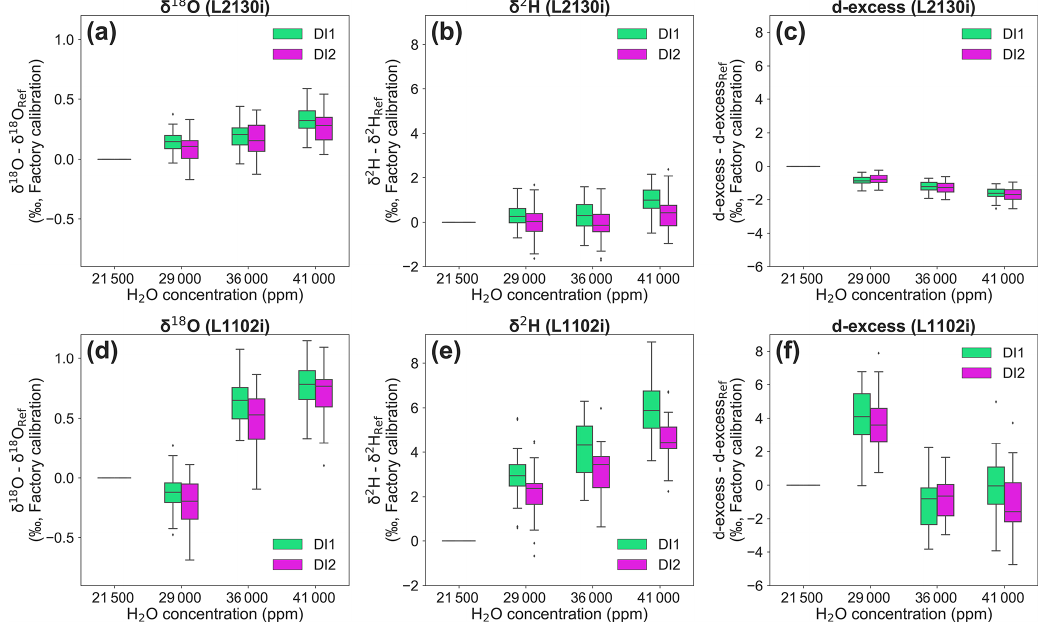
Figure 5. Deviations of stable isotopic compositions ( δ 18 O, δ 2 H, and d -excess) for each standard water (DI1 and DI2) at three different H 2 O concentrations compared to the 21500 reference H 2 O concentration. Box plots of (a) δ 18 O, (b) δ 2 H, and (c) d -excess deviations, measured by L2130i. Box plots of (d) δ 18 O, (e) δ 2 H, and (f) d -excess deviations, measured by L1102i. The δ 18 O, δ 2 H, and d -excess values at 21500ppm are assigned a value of 0, and [H 2 O] dependence for each isotope can be observed as the deviation between the value at each concentration level from the value measured at